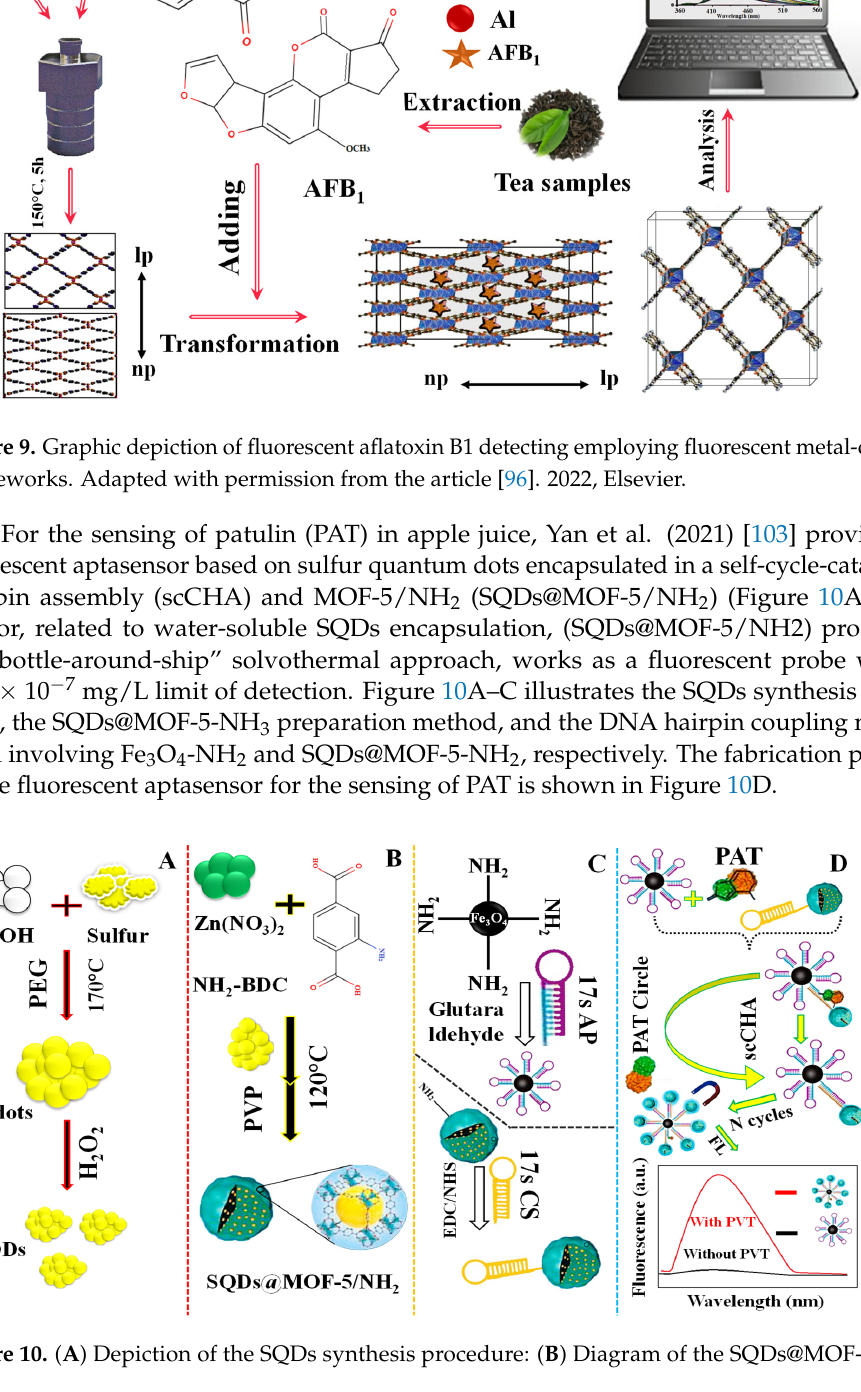
Figure 9. Graphic depiction of fluorescent aflatoxin B1 detecting employing fluorescent metal- organic frameworks. Adapted with permission from the article [96]. 2022, Elsevier.